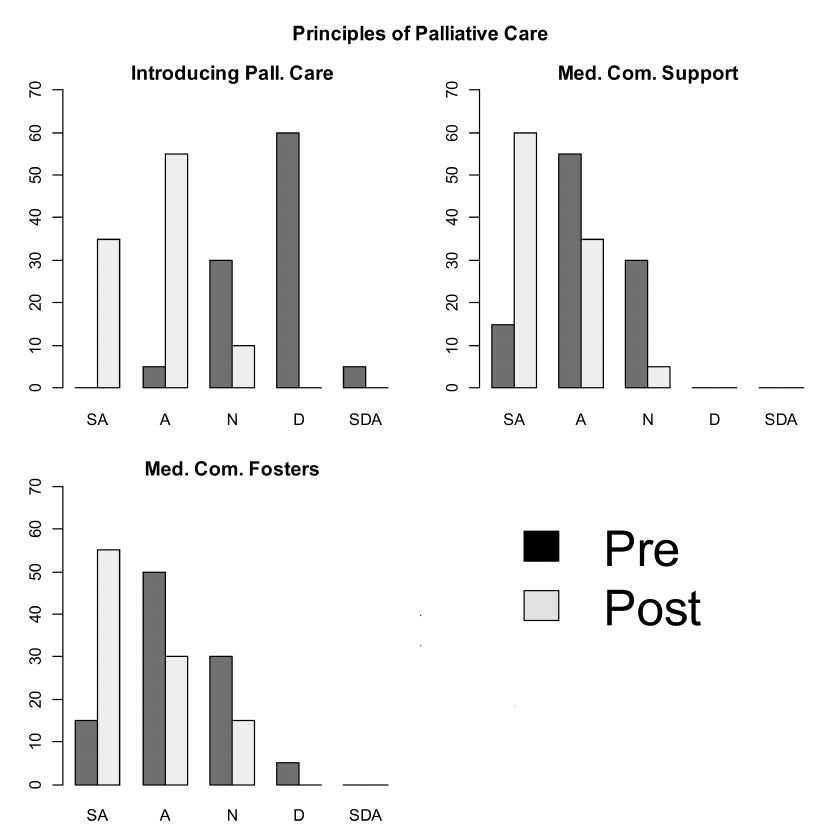
Figure 2. Perceived environmental receptivity to palliative care principles pre- and post-curriculum implementation. Abbreviation: Med. Com. Support = Medical Community Supports Palliative Care Principles; Med. Com. Fosters = Medical Community Fosters Palliative Care Principle Integration. Note that the Y-Axis refers to percentage of